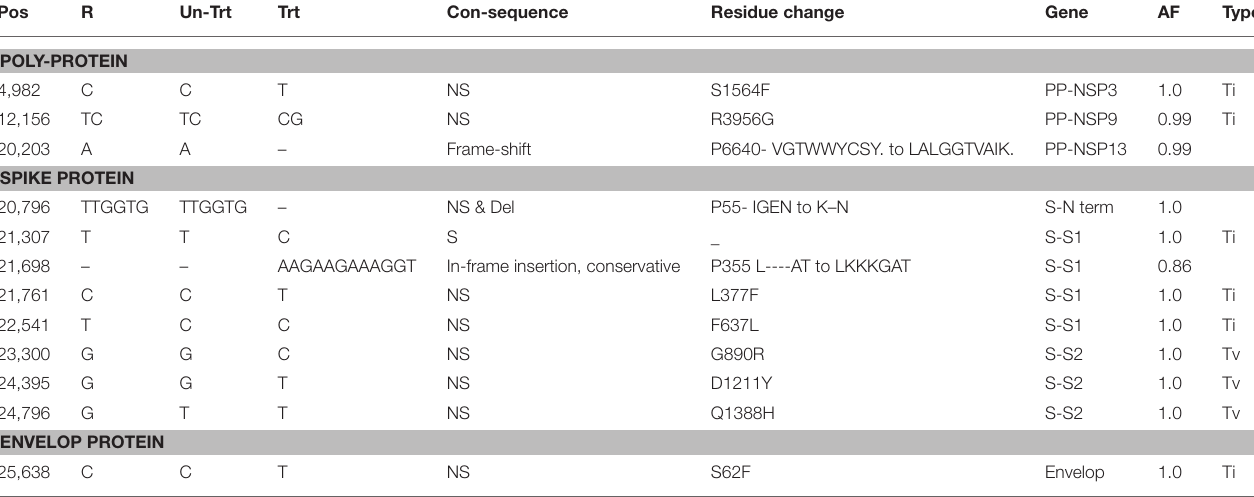
TABLE 2 | SNPs and